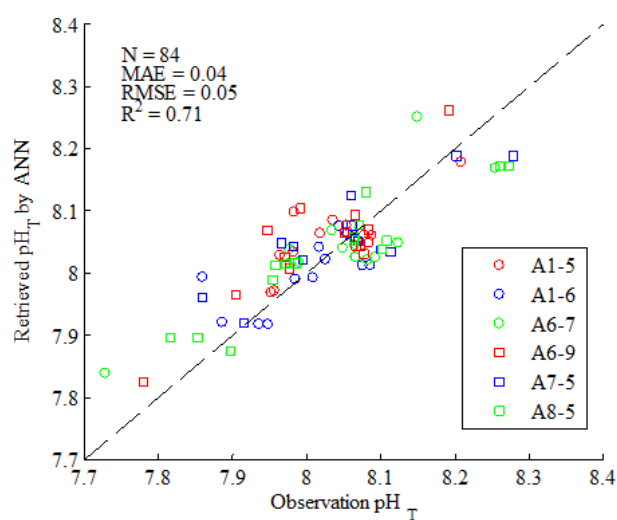
Figure 11. Comparison of water column pH T retrieved by the ANN model using Changjiang biology FVCOM output with correspond- ing observations at six sites with repeated sampling for 3 to 4 years. The 1 : 1 line is shown in the plot as a visual reference. Skill statis- tics include the mean absolute error (MAE), the coefficient of de- termination ( R 2 ) and the root mean square error (RMSE). N repre- sents the number of data